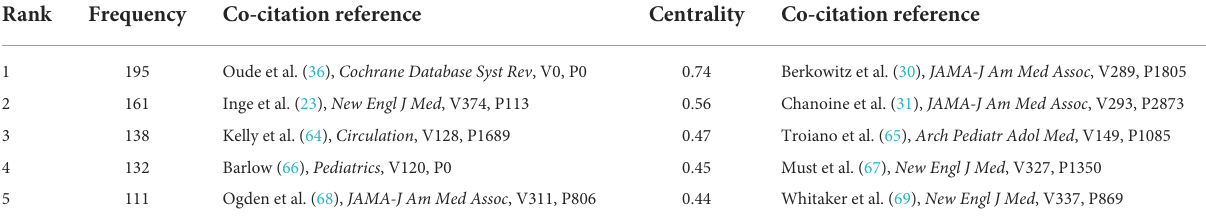
TABLE 5 Top five references by co-citation frequency and